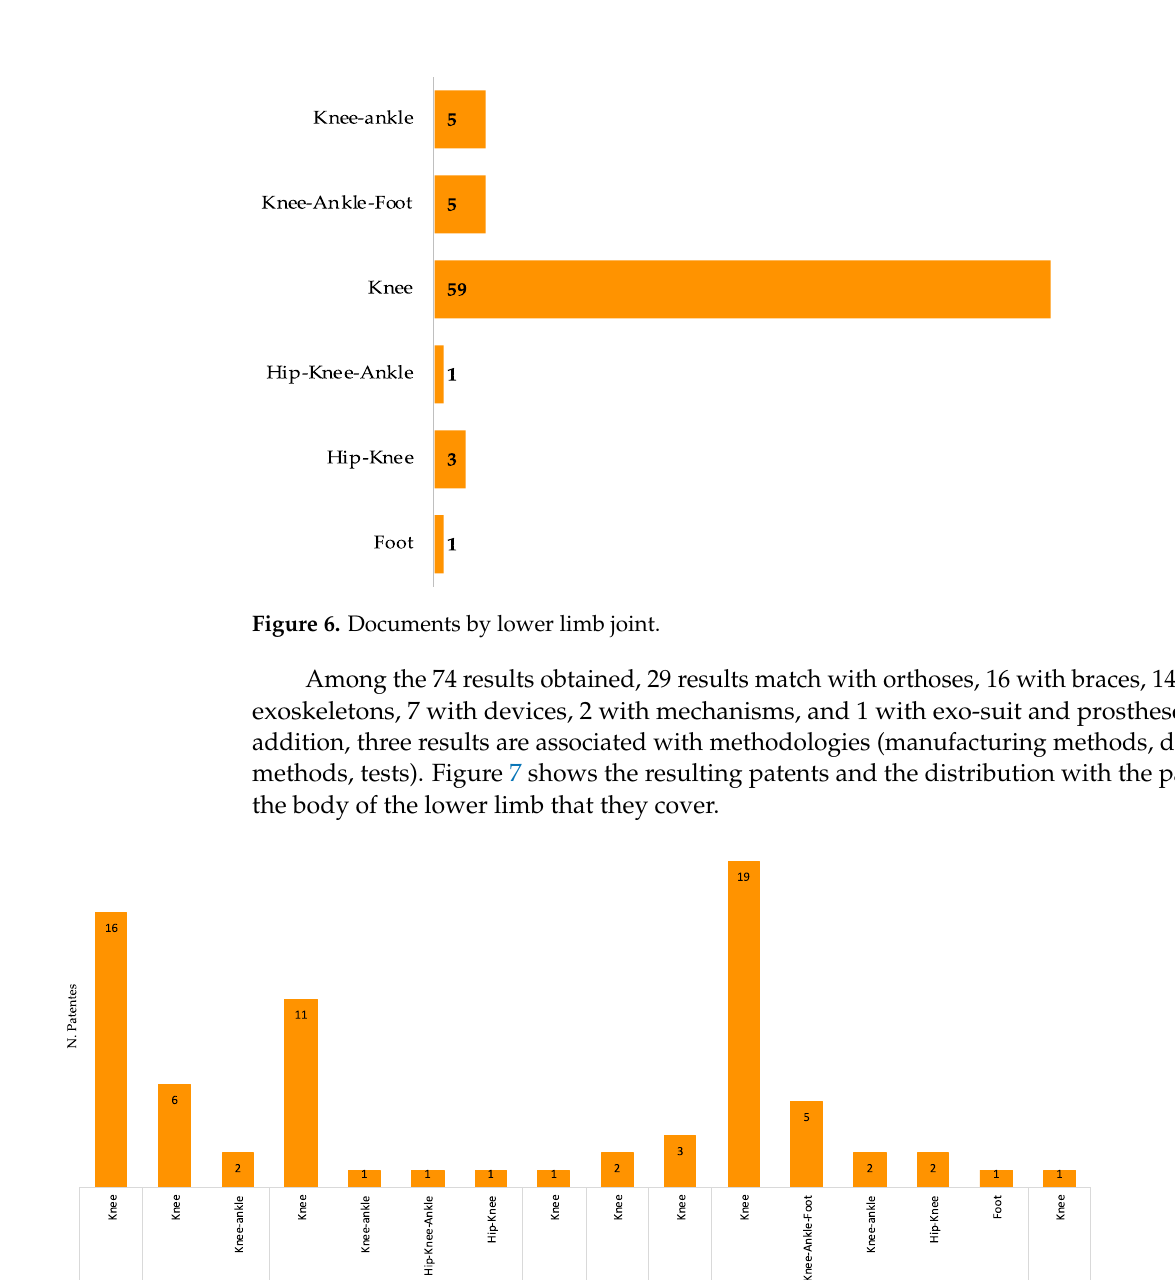
Figure 8. Type of technology used in the knee joint. Table 3. Lower limb exoskeletons and orthoses patents. Cite